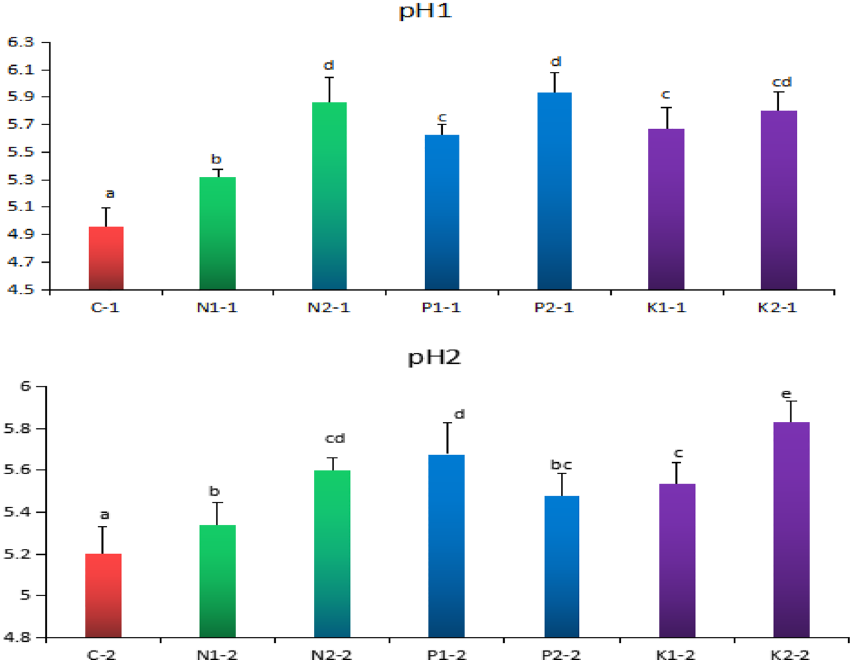
Figure 1. Effect of rice straw returning soil on soil pH value. Different letters indicate significant differences between potted rice in different soils, “ − 1” indicates tillering stage and “ − 2” indicates maturity stage, the same